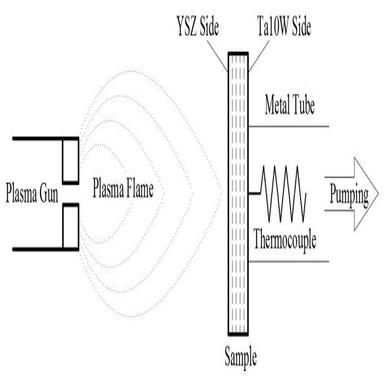
Ablation illustration.